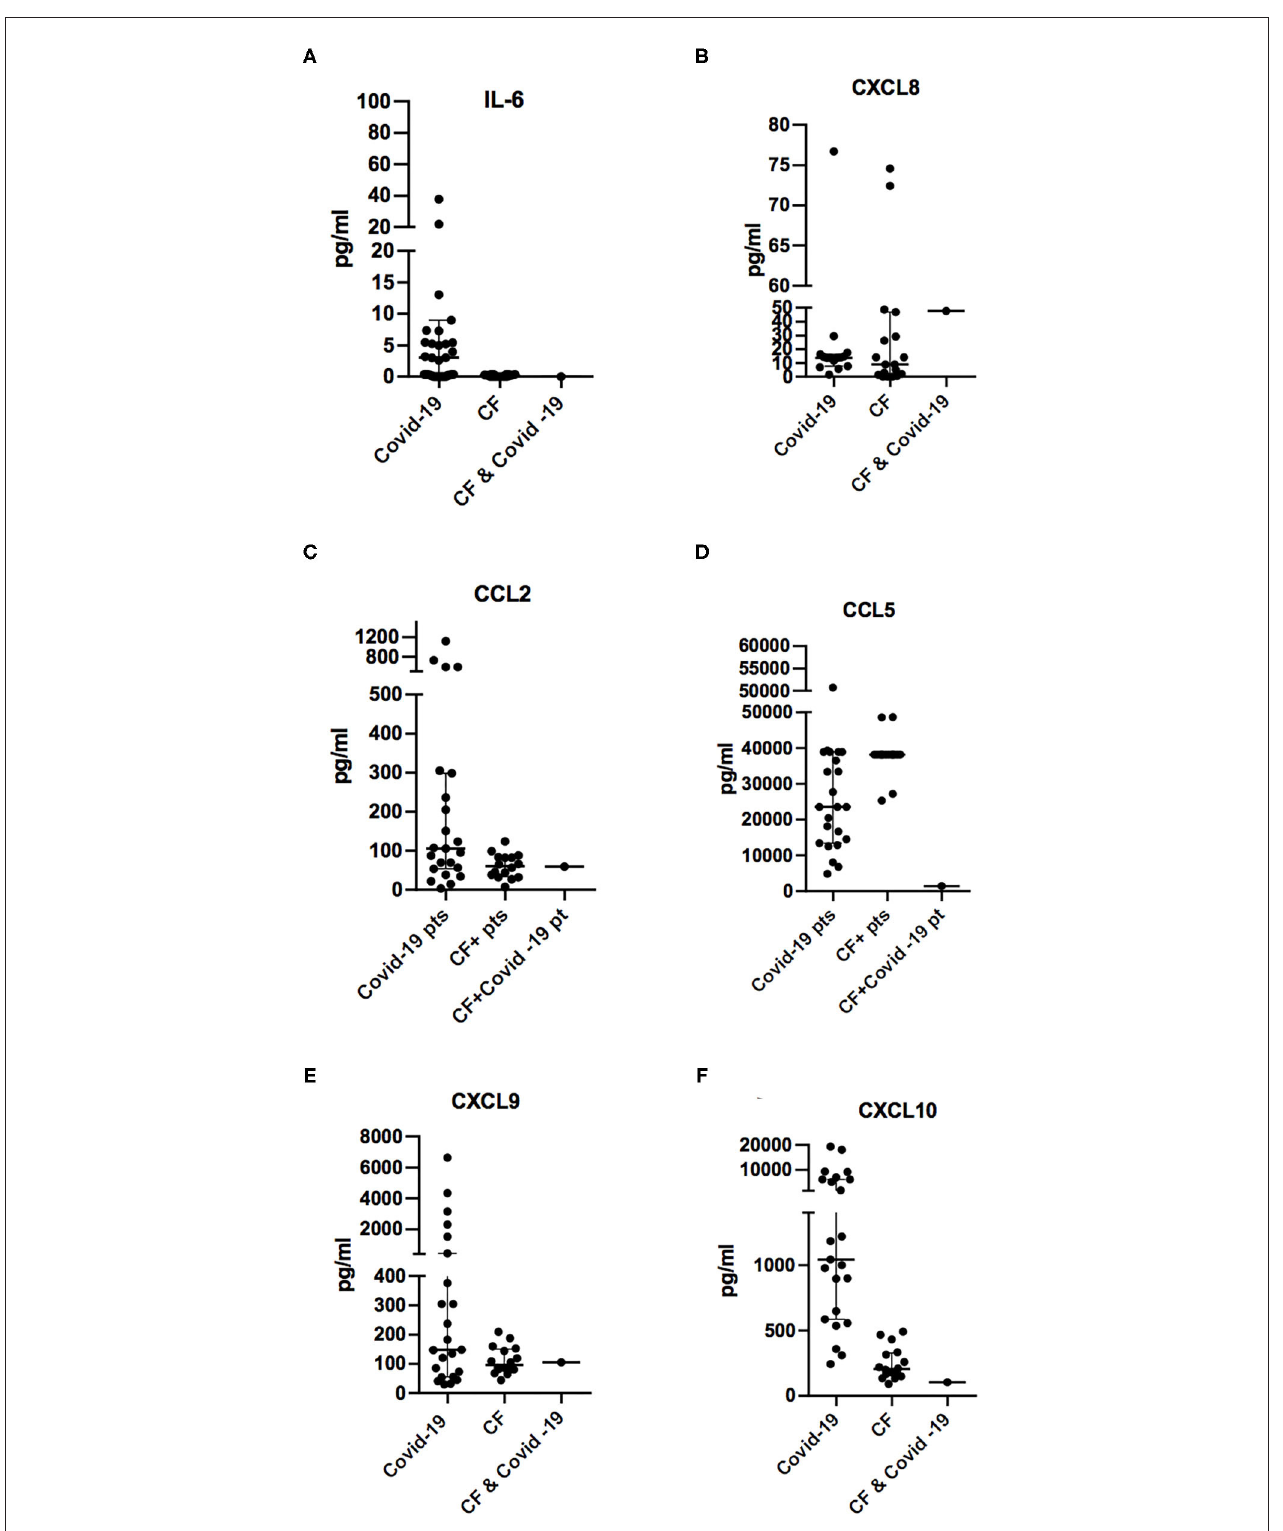
FIGURE 1 | Comparison of plasmatic concentrations of chemokines and cytokines IL-6 (A) , CXCL8/IL-8 (B) , CCL2/MCP1 (C) , CCL5/RANTES (D) , CXCL9/MIG (E) , and CXCL10/IP-10 (F) from otherwise healthy subjects during SARS-CoV-2 infection (COVID-19), cystic fibrosis patients not infected with SARS-CoV-2 (CF), and the 14-year-old CF patient in the acute phase of viral infections (CF and COVID-19). Concentration levels are reported in the groups as median ± IQR (pg/ml).